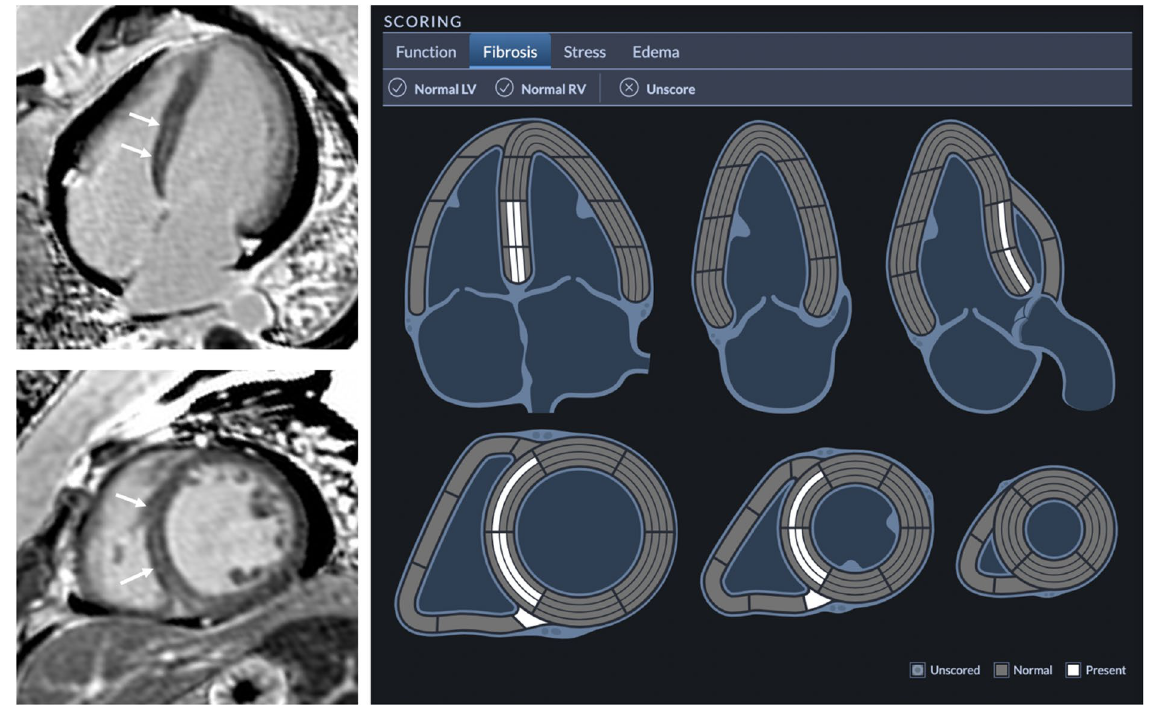
Figure 1. Example late gadolinium enhancement (LGE) reporting of mid-wall striae (MWS) pattern fibrosis in a 38-year-old female with dilated cardiomyopathy. Concurrent inferior right ventricular insert site fibrosis is also